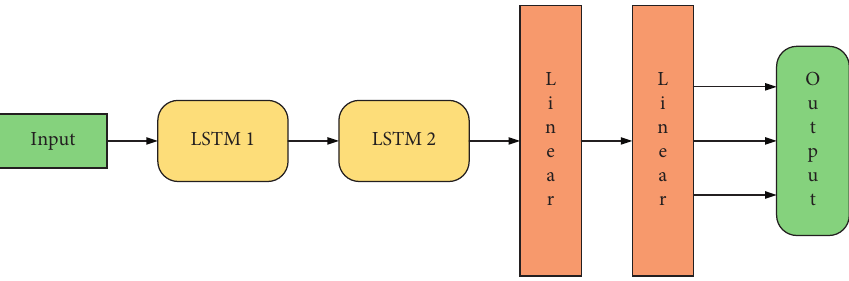
Figure 11: LSTM network structure. Table 5: Dimensions of each layer of the network.